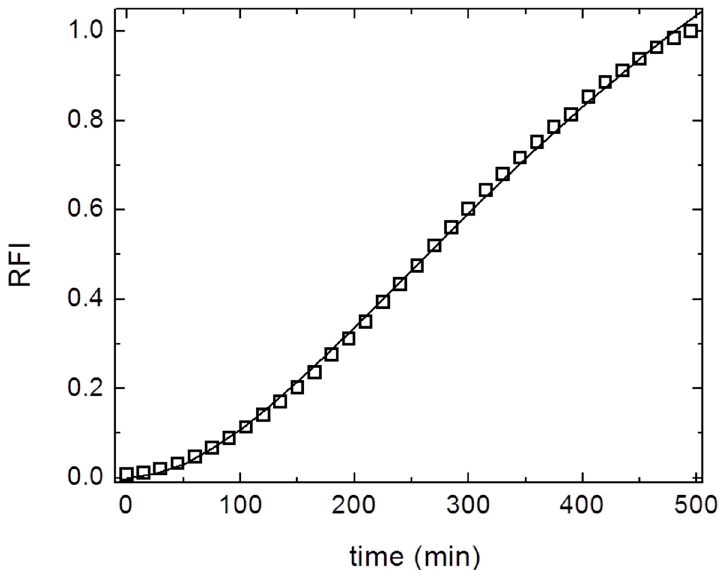
Figure 7. Relative fluorescence intensity (RFI) from integrated emission spectra obtained from lipase hydrolysis of QDB 2.0 × 10 − 5 mol ∙ L − 1 in hexane as a function of reaction time ( λ exc = 484 nm, 20 mg of Novozym 435). T = 298 K. The line is the fitting with the model given by Equation (1) (fitting quality evaluated by R 2 > 0.98).